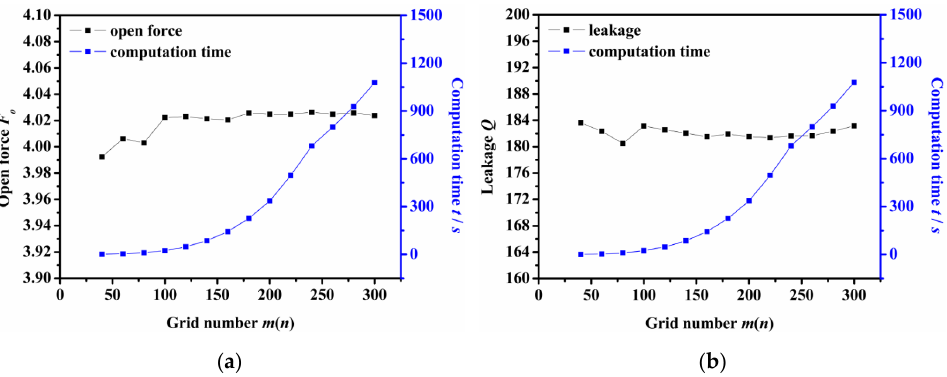
Figure 3. The influence of grid number on the calculation result: ( a ) opening force, ( b ) leakage rate.